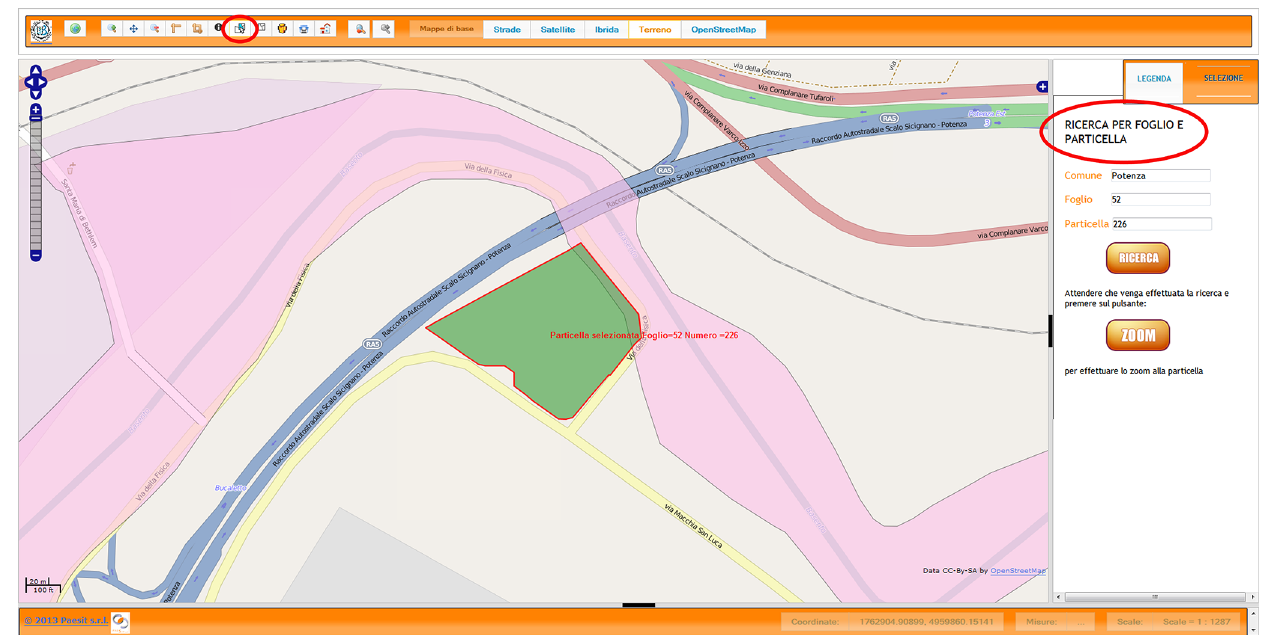
Figure 9. Example showing the cadastral particle in the Potenza municipality, used to check whether individual properties are in the flooded